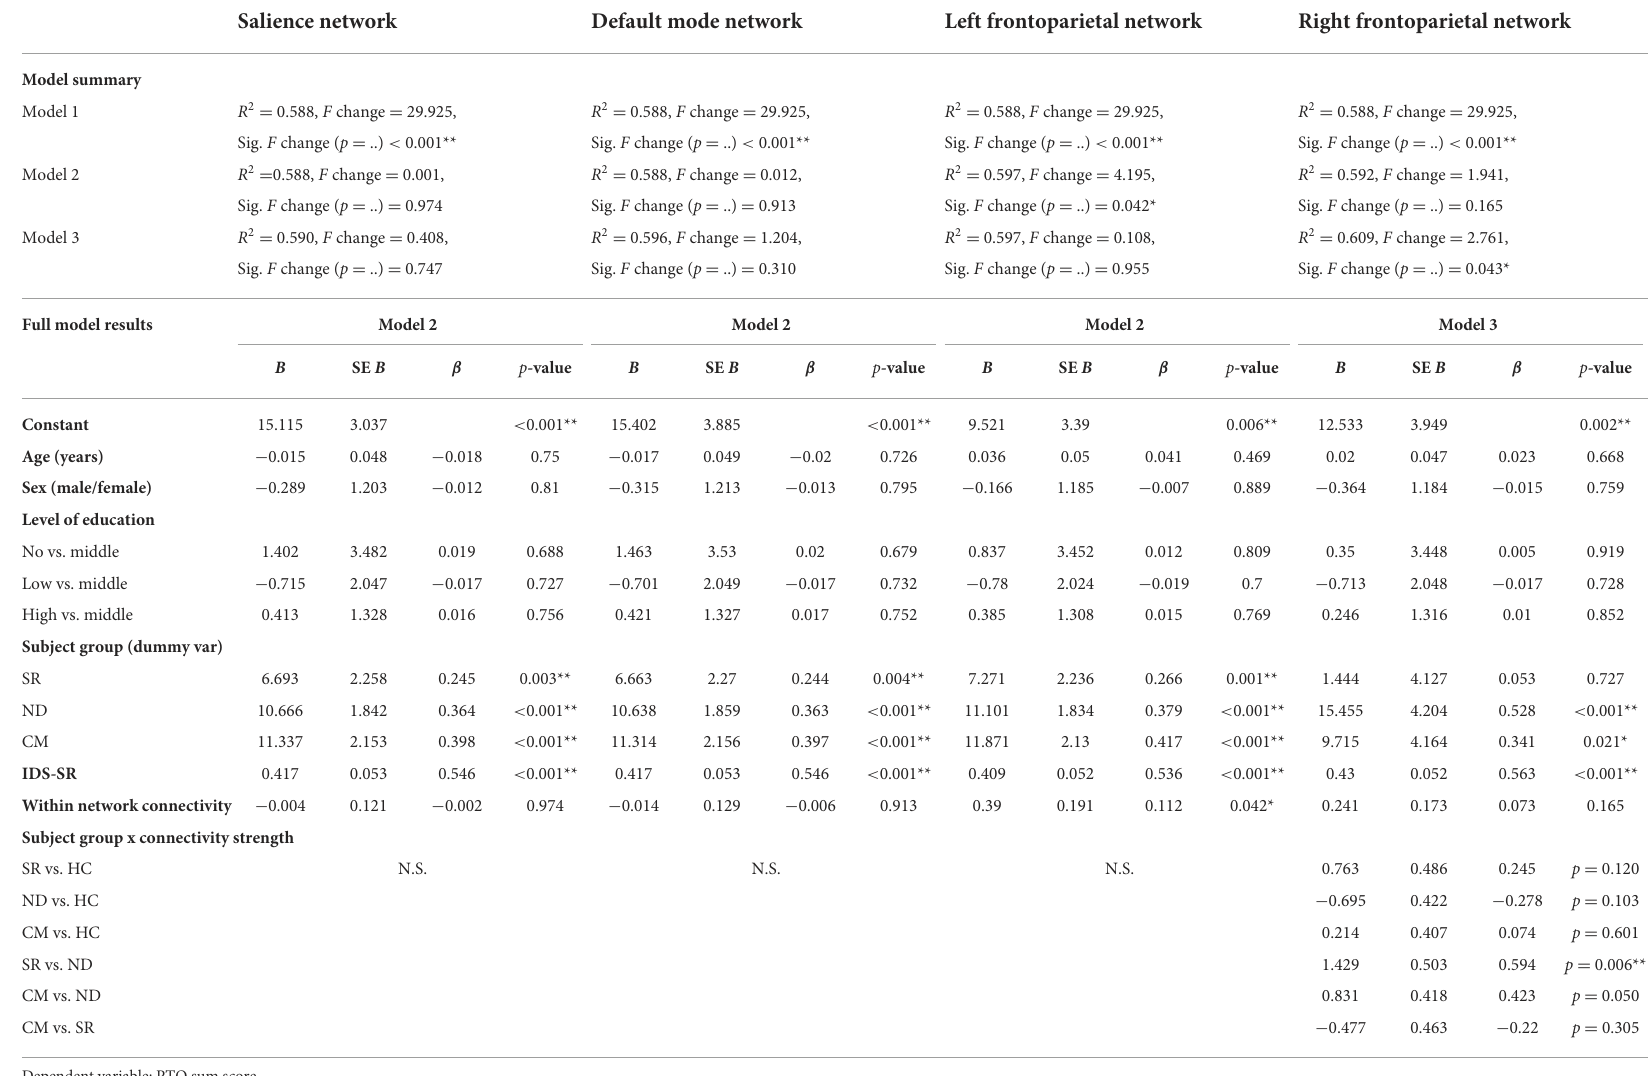
TABLE 2 Regression models: relationship between repetitive negative thinking (RNT) and baseline network connectivity